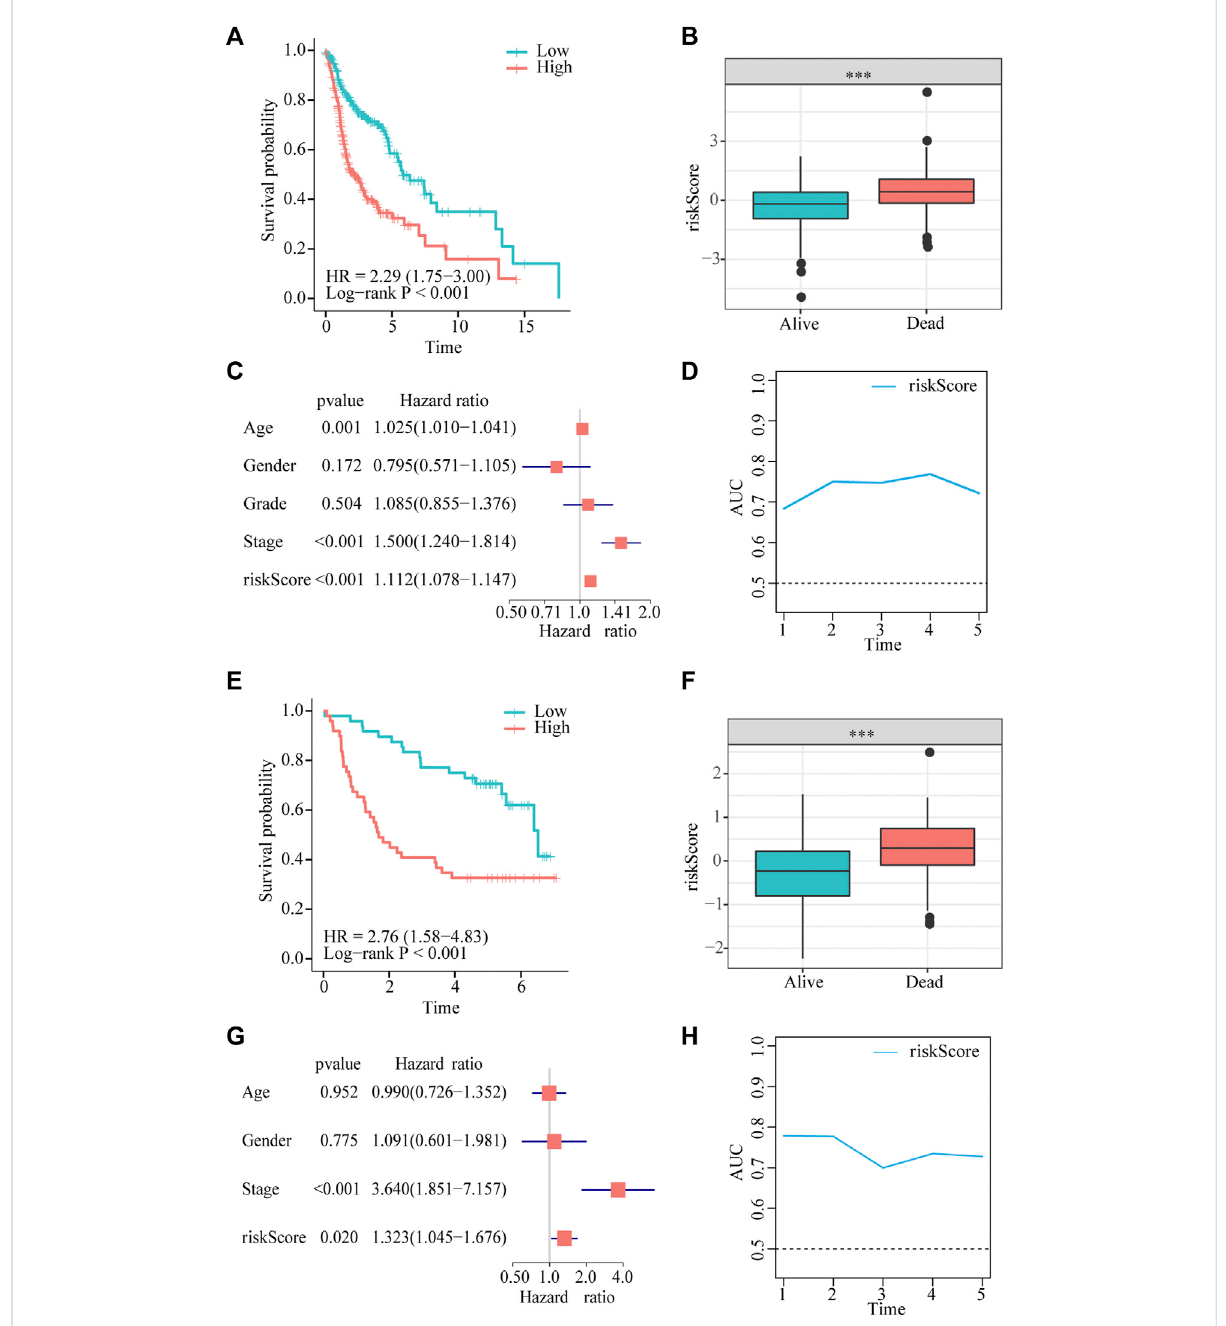
FIGURE 3 Genesignaturepredictsoverall survival(OS)inTCGAandGEOdatasets. (A,E) Kaplan-Meieranalysis showsthatHNSCCpatientswithhigher risk scores have a poor prognosis. (B,F) The risk score is signi fi cantly elevated in patients with HNSCC who died during the follow-up. (C,G) Multivariate Cox regression analysis shows that the risk score is an independent prognostic factor for OS. (D,H) tROC analysis shows that the risk score is an accurate variable for survival